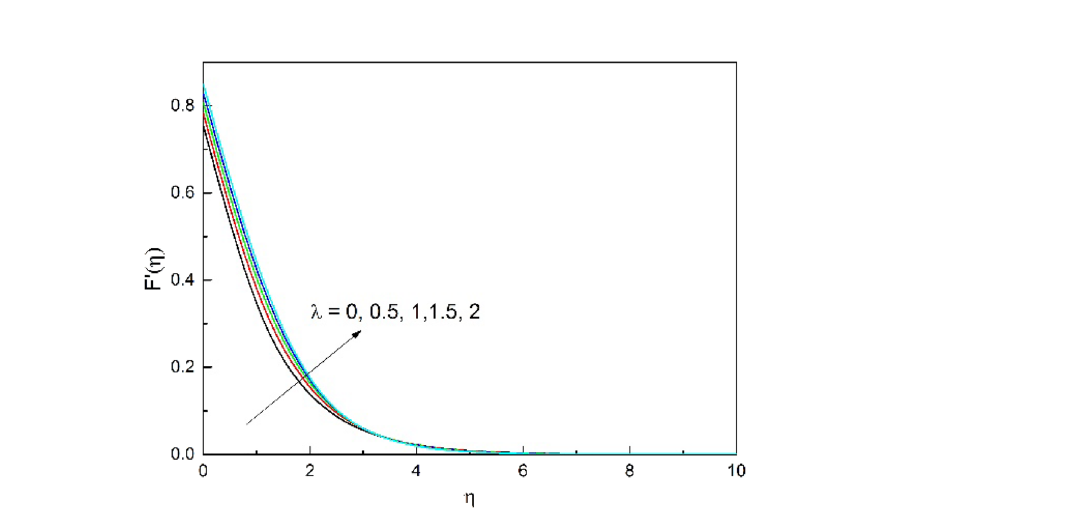
Figure 7. (cid:31) on F ′ (η) .